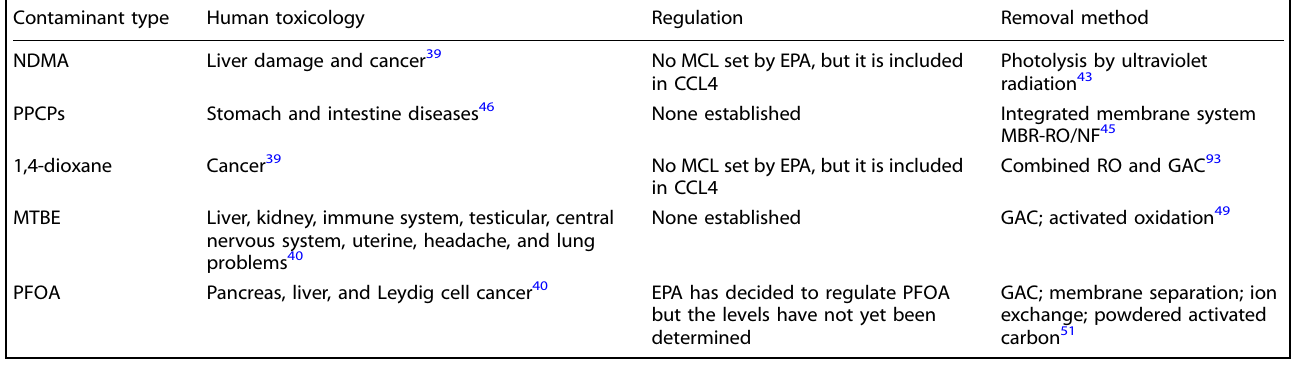
Table 5. Features of several CECs in drinking water.